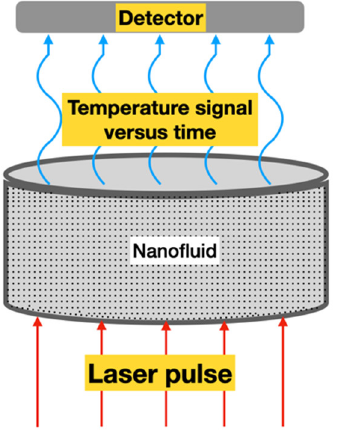
Figure 6. Laser flash measurement principle: an energy/laser pulse (red) heats the sample (gray) containing the nanofluid on the bottom side and a detector detects the temperature signal versus time on the top side (blue).